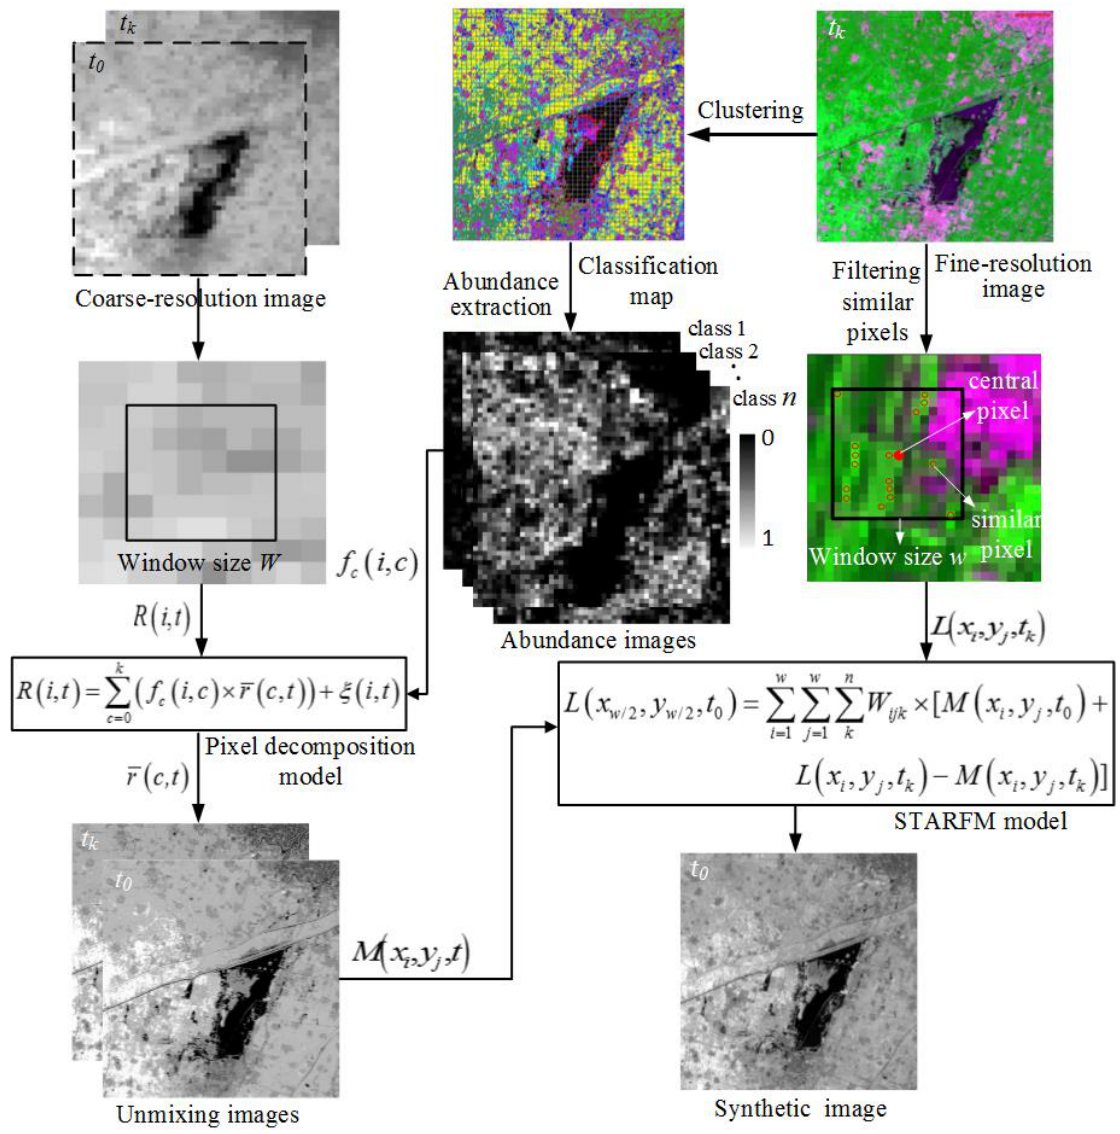
Figure 1. Flowchart of the USTARFM algorithm.